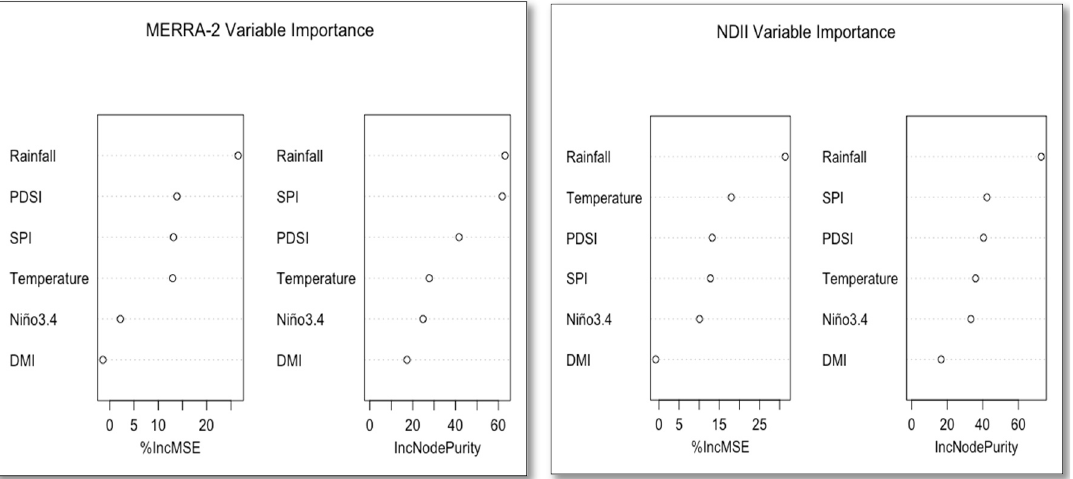
Figure 7. Mean Decrease Accuracy (%IncMSE) and Mean Decrease Gini (IncNodePurity) of attributes as assigned by the random forest for the NADI-MERRA–2 and NADI-NDII.